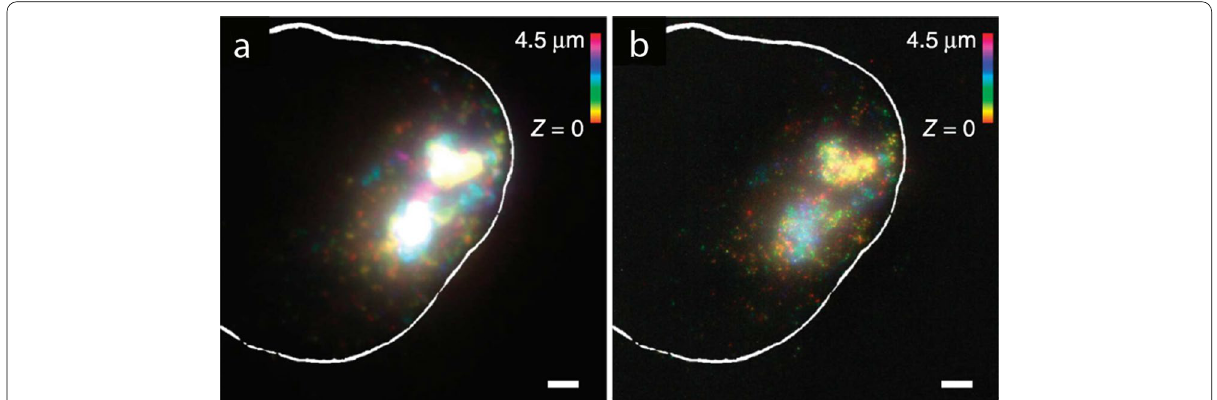
Fig. 8 a Single-molecule FISH (smFISH) image of XIST long non-coding RNA (lncRNA) in the nucleus of an HEK293 cell before expansion (the white line denotes the nuclear envelope). b As in a , using Expansion Fluorescence In Situ Hybridization (ExFISH). Scale bars, 2 μm (6.6 μm). (Reprinted/ adapted by permission from Springer Nature: Chen et al. [59], copyright